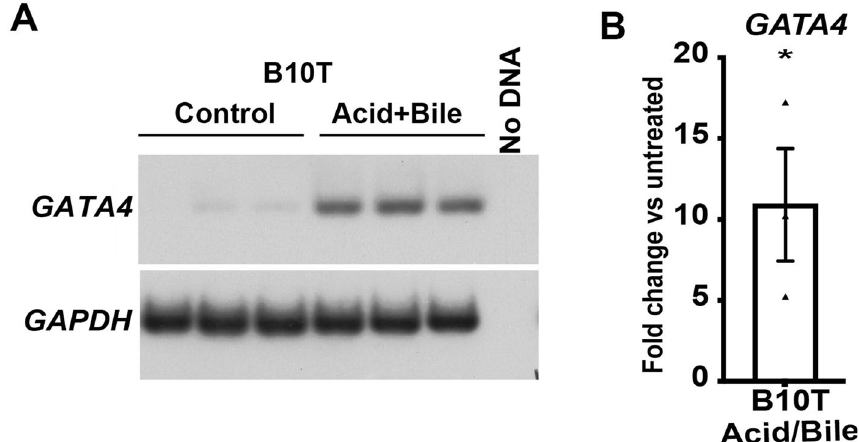
Figure 7. Acid and bile treatment of human esophageal cells in culture induces GATA4 mRNA expression. The human esophageal squamous epithelial cell line NES-B10T was treated with acidified media (pH 5.5) containing a mixture of bile salts (20:3:15:3:6:1, final concentration 400 mM: glycocholic, taurocholic, glycochenodeoxycholic, taurochenodeoxycholic, glycodeoxycholic, and taurodeoxycholic acids) for 48 h before RNA extraction and semi-quantitative RT-PCR in the presence of [α- 32 P] dATP to detect the steady- state level of GATA4 mRNA. Amplicons were separated by PAGE and visualized using autoradiography and phosphorimaging. ( A ) Representative image showing GATA4 mRNA induced by acid and bile treatment of NES-B10T cells. GAPDH was used for normalization. ( B ) Phosphorimager quantification of data from three independent experiments demonstrated that GATA4 mRNA was induced 10.9-fold in acid and bile treated NES- B10T cells (n = 3; *P ≤ 0.05) compared with non-treated control cells. The full autoradiograph used to generate panels is shown in Supplementary Fig.